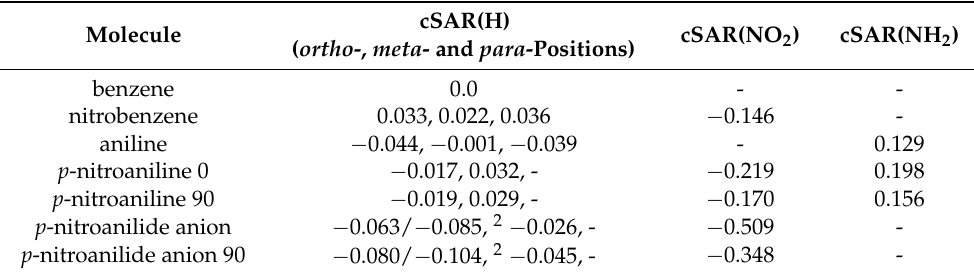
Figure 8. Voronoi deformation density (VDD) atomic charges (in electrons) for benzene and its derivatives (C s symmetry for all systems has been imposed). Table 1. cSAR(X) values (in electrons) for substituents in ortho -, meta - and para - positions of benzene and its nitro and amino derivatives 1 .